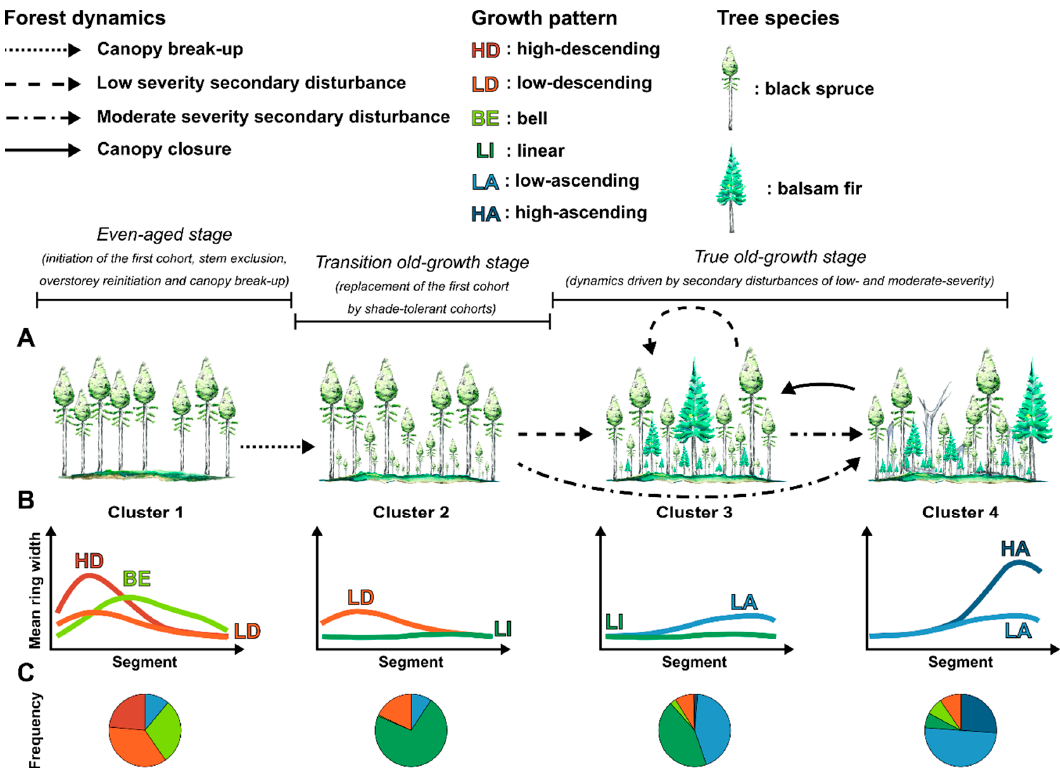
Figure 5. Conceptual model of changes in ( A ) forest structure, ( B ) growth pattern forms, and ( C ) growth pattern frequency during and after the transition toward the old-growth stages, depending on forest succession and disturbance dynamics. Water paintings by Valentina Buttò.